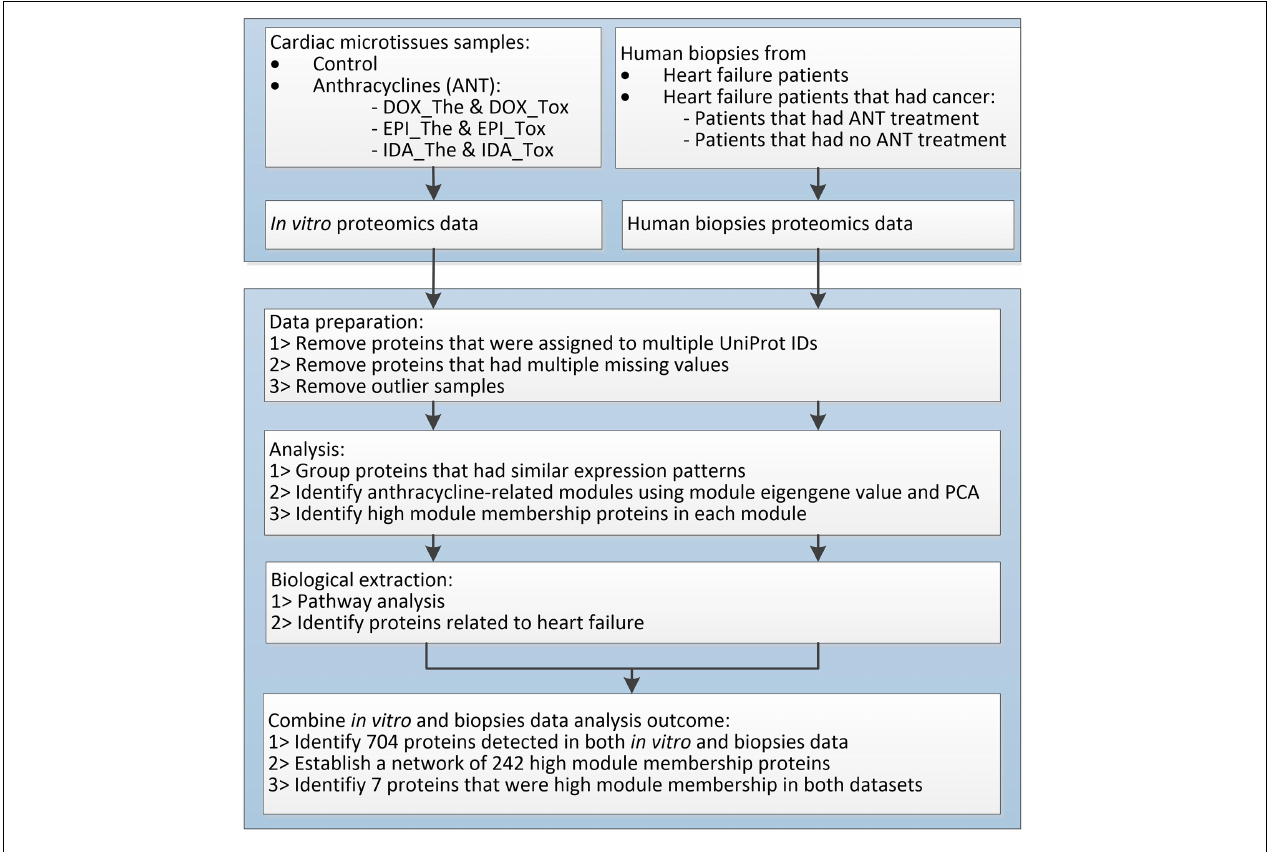
FIGURE 2 | The proteomic data analysis